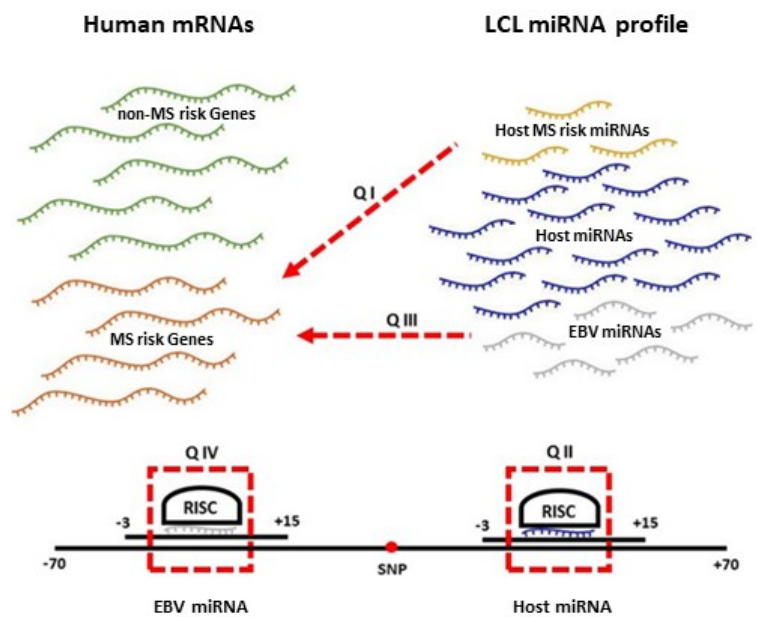
Figure 1. The possible interactions between LCL miRNAs and host/EBV mRNAs which could be involved in MS pathogenesis: (I) Host MS risk miRNAs may target MS risk genes (II) host miRNA binding sites among MS risk genes may be affected by MS risk SNPs (III) EBV miRNAs may target MS risk genes (IV) EBV miRNA binding sites among host MS risk genes may be affected by MS risk SNP.